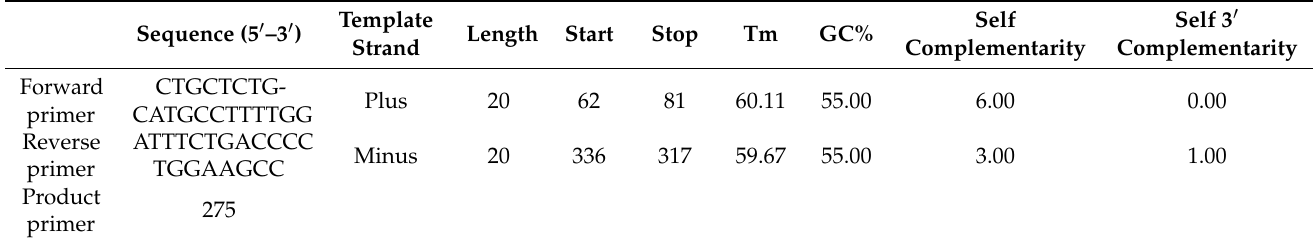
Table 1. The primers used for genotyping.